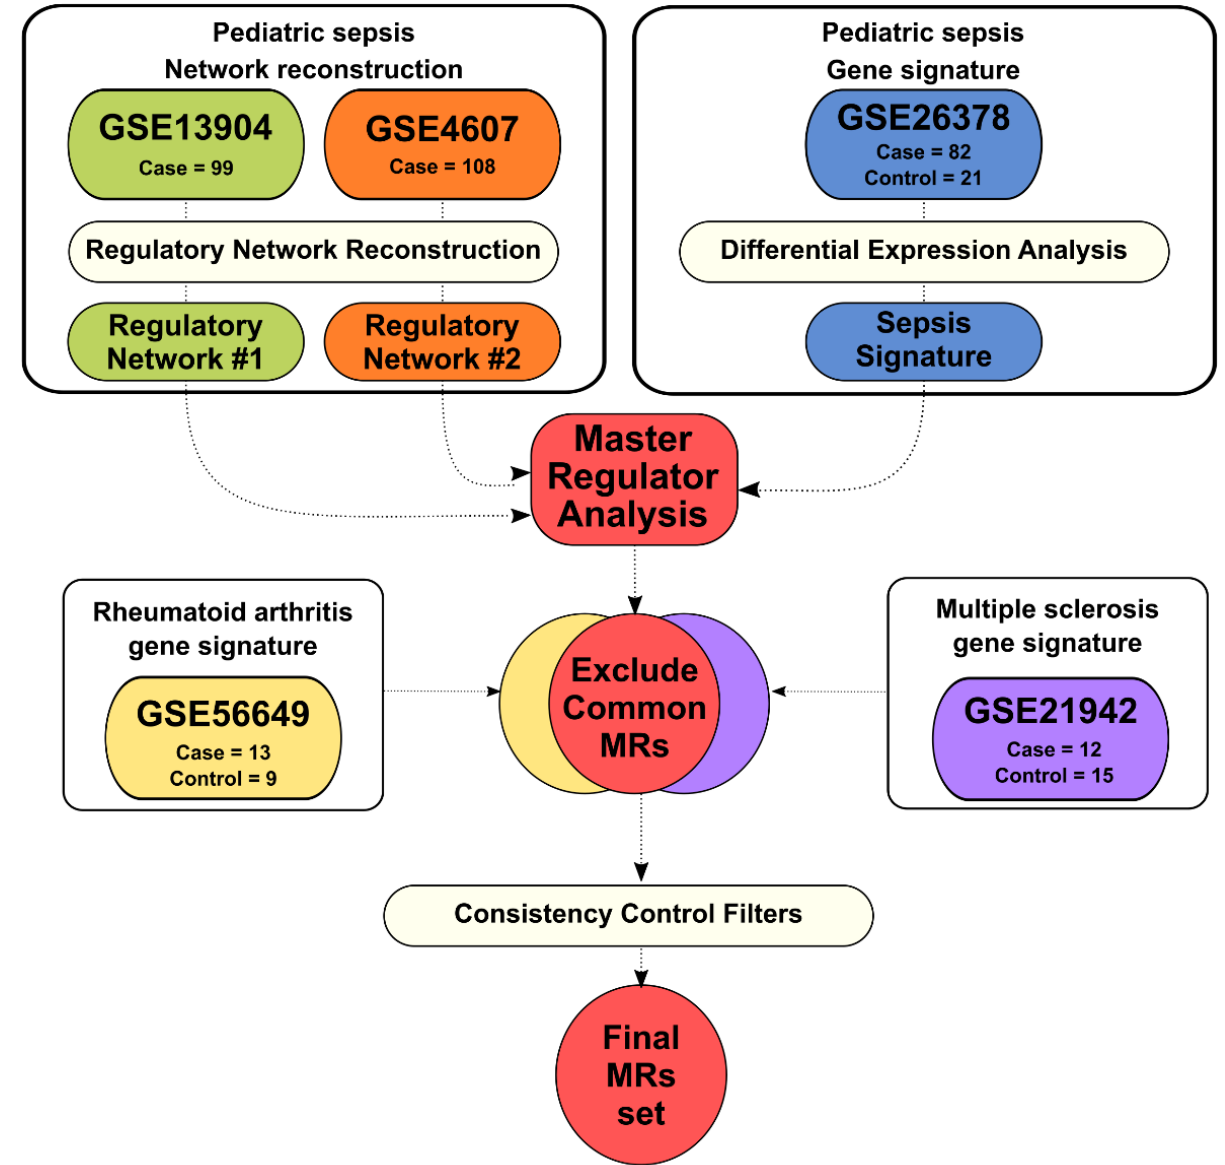
Figure 1. Flowchart of the sepsis regulatory network inference and identification of master regulators. Two independent cohorts were used to infer the networks (GSE13904 and GSE4607) and one cohort was used to build the pediatric sepsis gene signature (GSE26378). The networks were further analyzed by two different gene signatures (GSE56649, rheumatoid arthritis; GSE21942, multiple sclerosis). In the end, a set of 15 master regulators were found: ZNF529 , GATA3 , KLF12 , RORA , HOXB2 , NR3C2 , ZNF329 , RFX2 , ZKSCAN8 , ZNF331 , ZNF235 , MEF2A , ZNF234 , ZNF134 , TRIM25 .